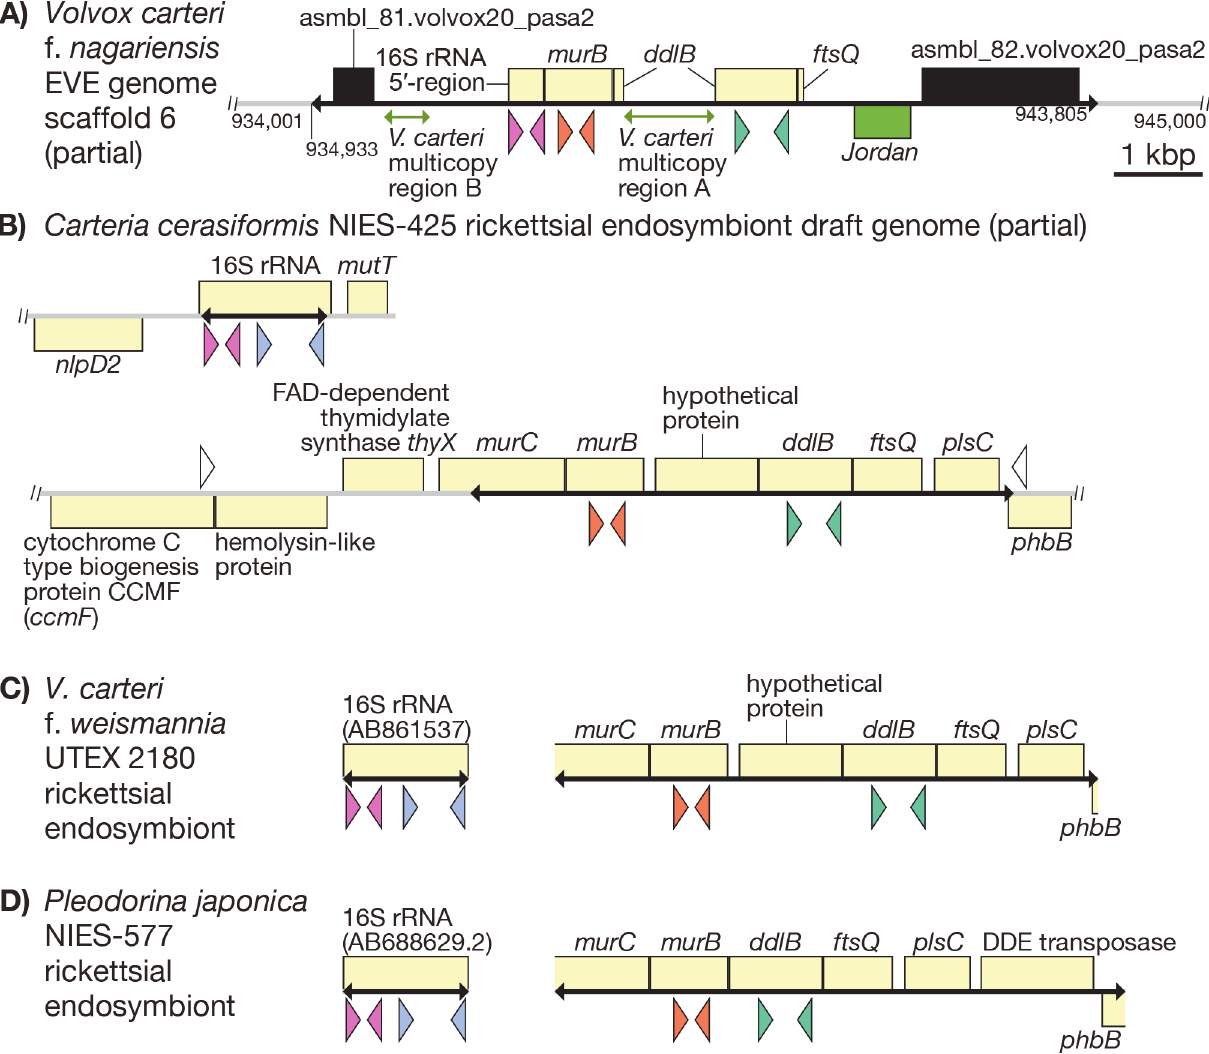
Fig 1. Rickettsial genes and gene-like sequences in the genomes of Volvox carteri and rickettsial possible endosymbionts. Schematic representations of arrangements/synteny of several rickettsial genes and gene-like sequences present in DNA of the nuclear genome of V . carteri (A) and in the genomes of rickettsial possible endosymbionts harbored by three volvocalean species (B-D). Coding DNA sequences (CDSs) and CDS-like regions are shown as boxes. Rickettsial CDSs/CDS-like regions are shown in pale yellow, the V . carteri transposon Jordan -like region in green and others in black. Placement of boxes above/below the line indicates gene direction (from left-to-right or right-to-left, respectively). Black double-headed arrows on the baseline indicate the regions sequenced in the present study. Colored triangles under boxes indicate the locations of primers used for semi-quantitative genomic PCR (16S rRNA gene 5 0 -region: magenta, 16S rRNA gene 3 0 -region: light blue, murB : orange, ddlB : green; Fig. 2E). For accession numbers of sequences used in this figure, see S3 Table. (A) Part of scaffold 6 of the V . carteri f. nagariensis strain EVE nuclear genome. (B) Part of the Carteria cerasiformis NIES-425 draft endosymbiont genome, including 16S rRNA (first line) and murB - ftsQ (second line). White triangles indicate primers used to amplify the sequencing templates (ccmF-R02 and phbB-F01; see Materials and Methods). (C) Part of the genome of a possible endosymbiont of V . carteri f. weismannia strain UTEX 2180, including murB and ddlB (right). The 16S rRNA gene of the endosymbiont [12] is also shown (left). (D) Part of the genome of a possible endosymbiont of Pleodorina japonica strain NIES-577, including murB and ddlB (right). The 16S rRNA gene [11] is also shown (left).